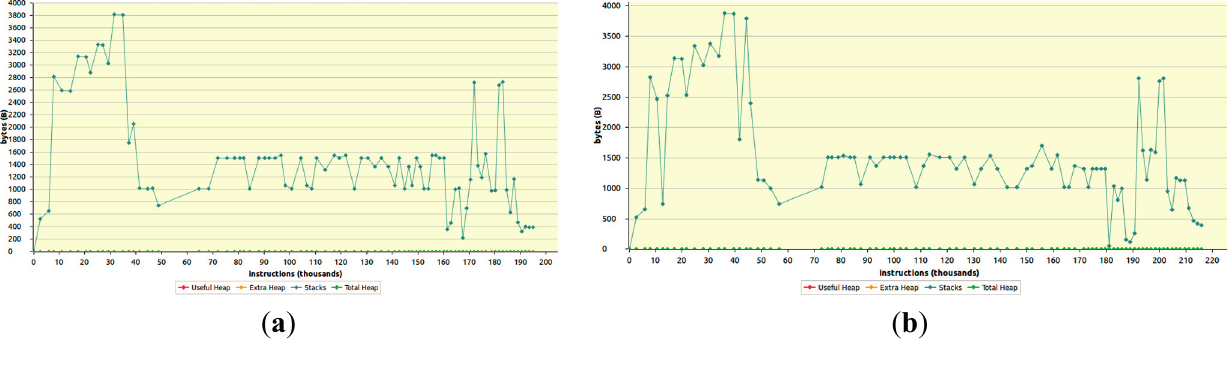
Figure 10. RAM consumption for ICMetric based AES encryption/decryption ( a ) 128-bit; ( b )